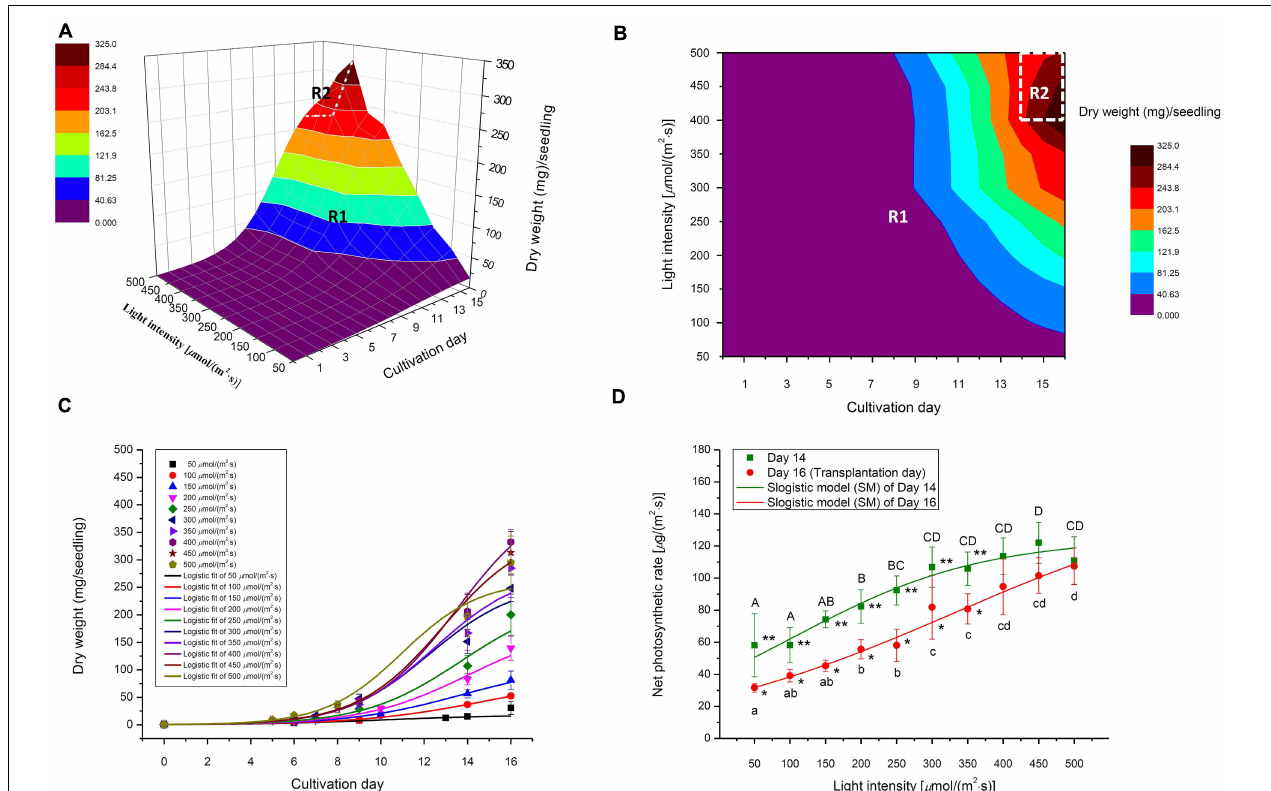
FIGURE 7 | (A) Selected 3D light-time-biomass response model, (B) the light-intensity-and-time- based dry weight contour of selected 3D model, (C) selected 2D time-based growth model, and (D) Net photosynthetic rate (2D light response model) of choy sum seedling grown under different white LED light intensities and duration. R1 and R2 stand for Region 1 and Region 2 of the selected 3D light-time-biomass response model, respectively. Different upper cases (A, B, C, D) and lower cases (a, b, c, d) indicate significant differences among all the light intensities tested on Day 14 and Day 16, respectively ( n = 6, one-way ANOVA; Tukey multiple comparison; p < 0.05). The asterisks (* and **) indicated significant differences between Day 14 and Day 16 ( n = 6, Student’s t test, p <